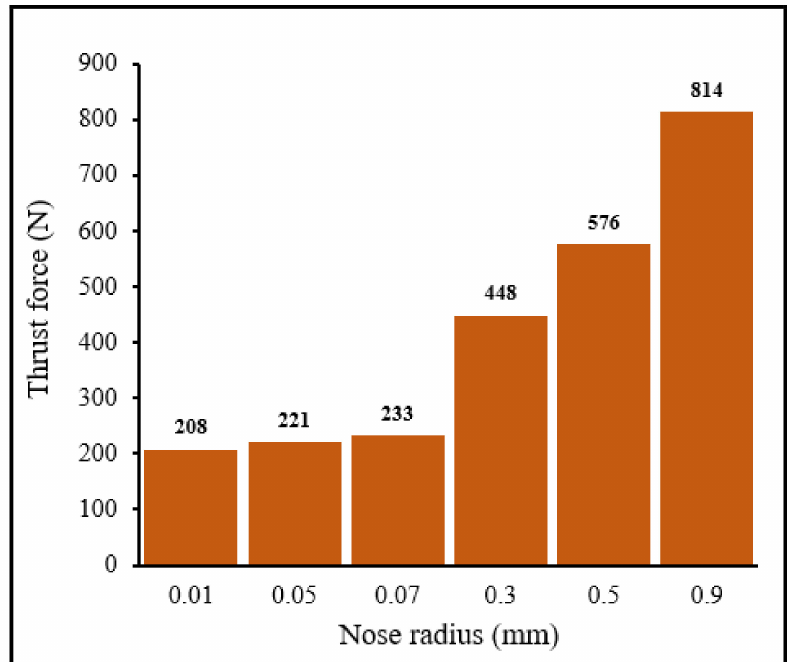
Figure 10. Distribution of thrust force for different tool nose radii V = 104 m/min, f = 0.1 mm/rev, γ = 15 ◦